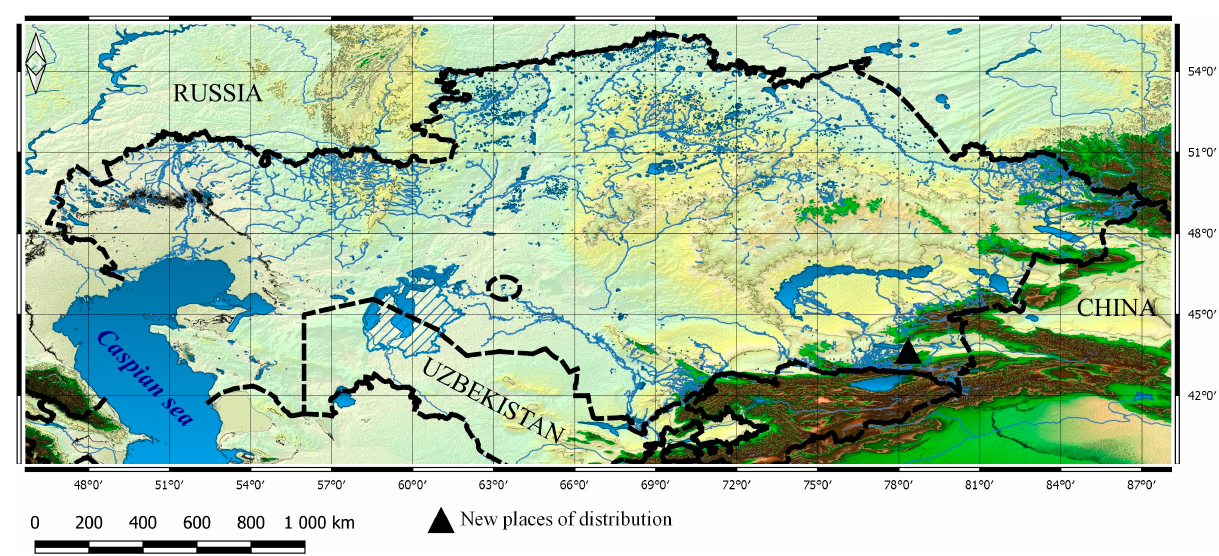
Figure 8. Distribution of Dactylorhiza majalis subsp. baltica (Klinge) H.Sund. in Kazakhstan. Ile Kungei Alatau: Kungei Ala-Too, Zhalanashsai gorge, 11.VII.1996, S.K. Mukhtubaeva (AA!):